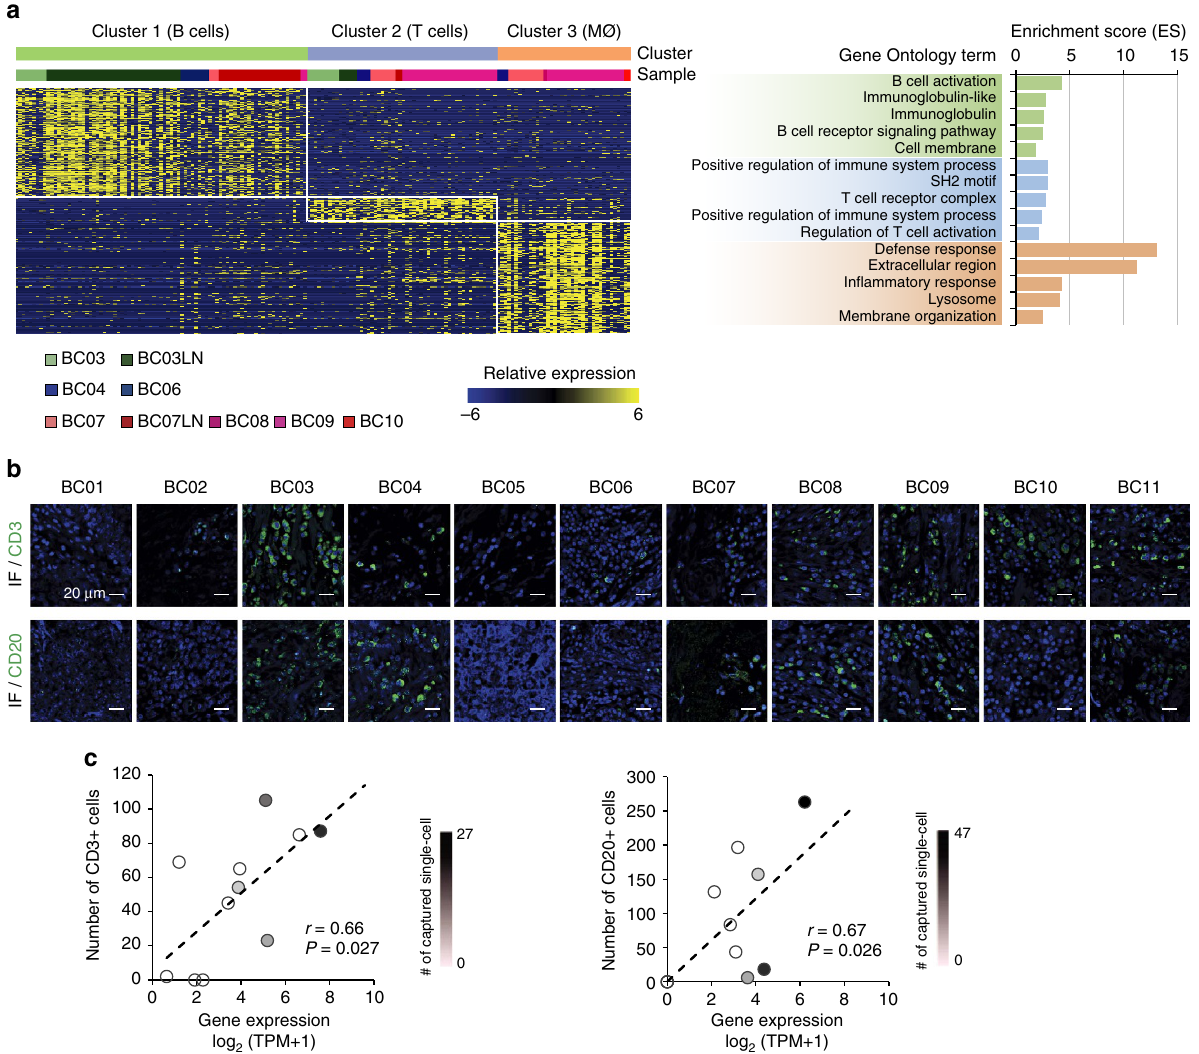
Figure 6 | Identification of immune cell populations in the tumour microenvironment. ( a ) Immune cell clusters were characterized by gene ontology terms. The cluster-specific genes extracted by LRT test (left) were associated with B cells, T cells or macrophages (MØ), respectively (right). ( b ) Immunofluorescence staining (IF) for CD3 or CD20 showing the infiltration of T or B lymphocytes in tumour tissues. Scale bar, 20 m m. ( c ) Immunofluorescence staining results show significant correlations with gene expression in bulk tumour samples (Pearson’s r , 0.66 for CD3 and 0.67 for CD20, P o 0.05). The linear regression result is drawn as a dashed line. Number of captured single cells is marked with a colour